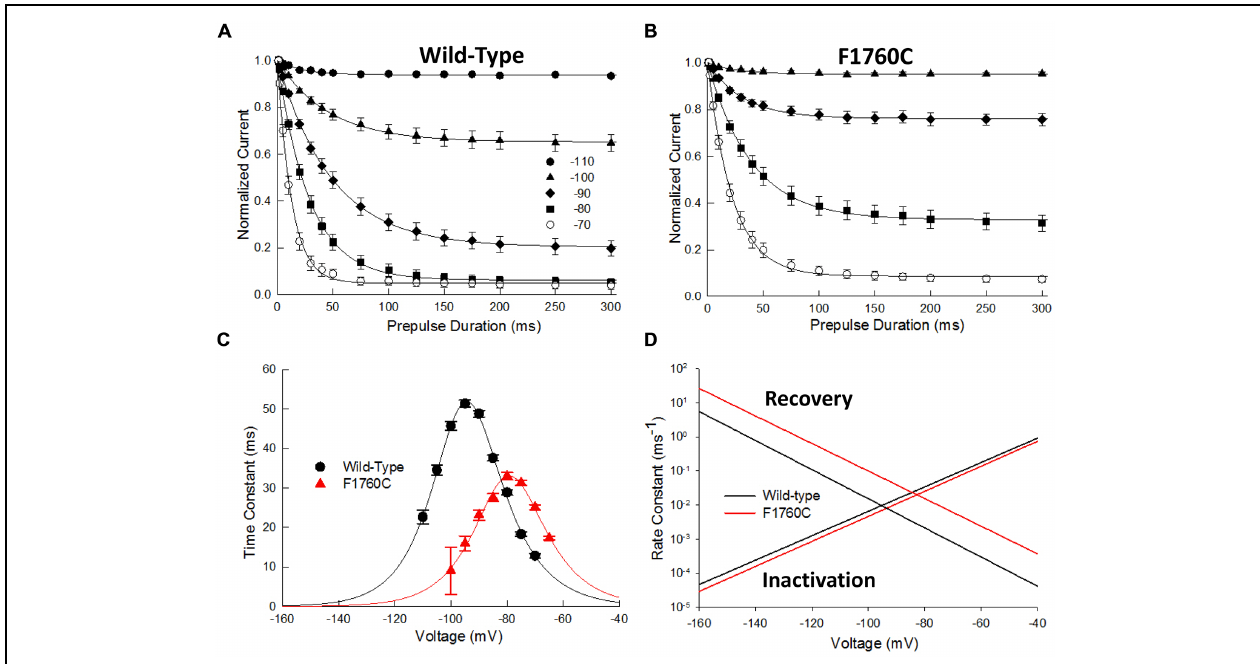
FIGURE 8 | The F1760C mutant alters closed-state inactivation. The onset of closed-state inactivation was measured by applying variable length prepulses (0–150 ms) to voltages between –110 and –70 mV. The cells were then returned to –140 mV for 1 ms before assessing availability with a standard test pulse to –10 mV for 20 ms. The peak currents were normalized and plotted versus the prepulse pulse duration. (A,B) Onset of